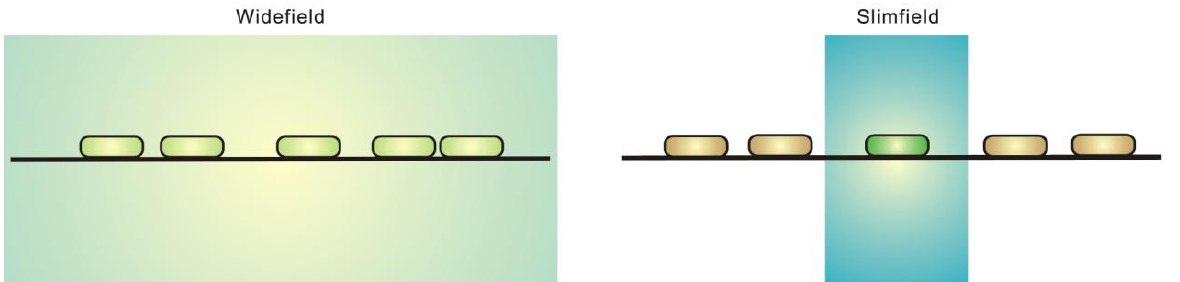
Figure 5. Slimfield illumination. Conventional wide-field fluorescence microscopy illuminates a wider field of the sample by lower excitation intensity, while slimfield microscopy concentrates the excitation light into a smaller area with greater excitation